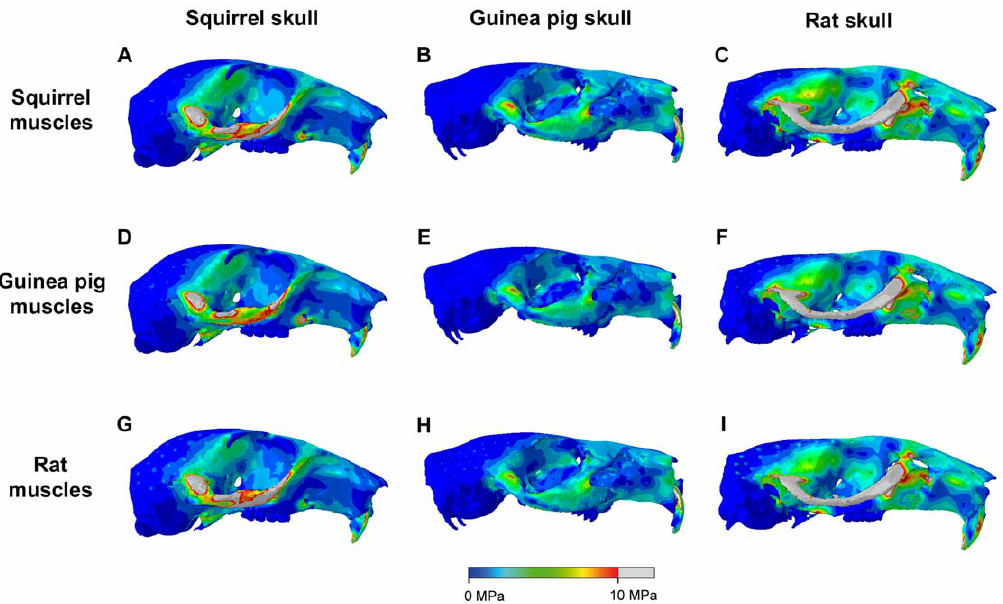
Figure 5. Predicted distribution of von Mises stresses across the skull. Incisor biting in squirrel (A,D,G), guinea pig (B,E,H) and rat (C,F,I), each loaded with squirrel (A–C), guinea pig (D–F) and rat muscles (G–I). Grey areas indicate von Mises stresses exceeding 10 MPa.